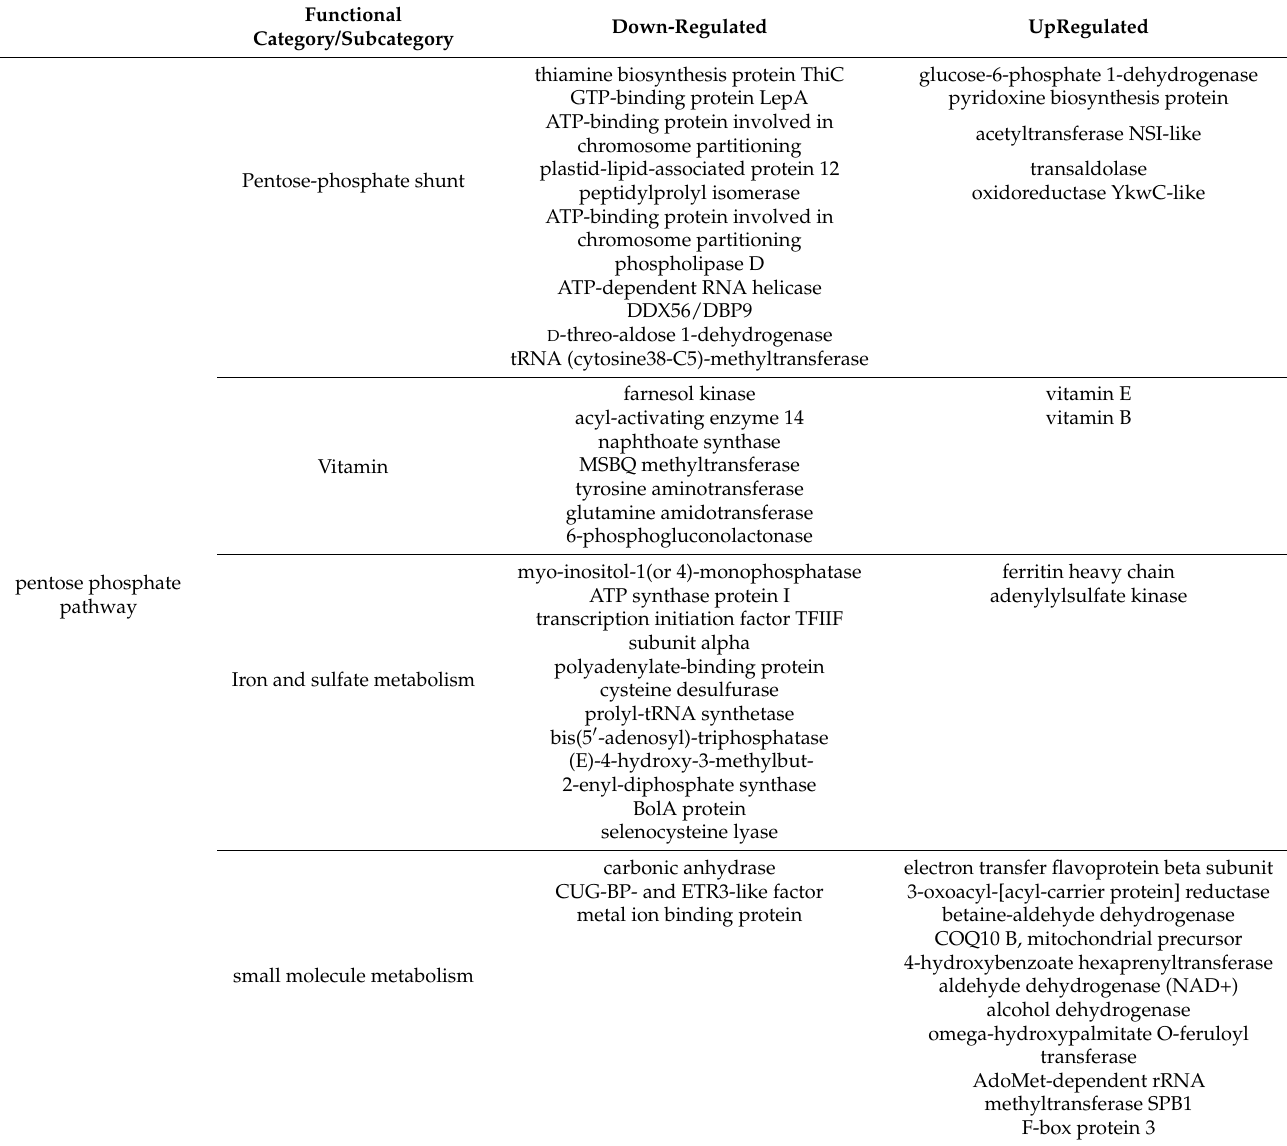
Table A6. The top 10 enzymes with the largest differences in seven pathways for which gene shifts were